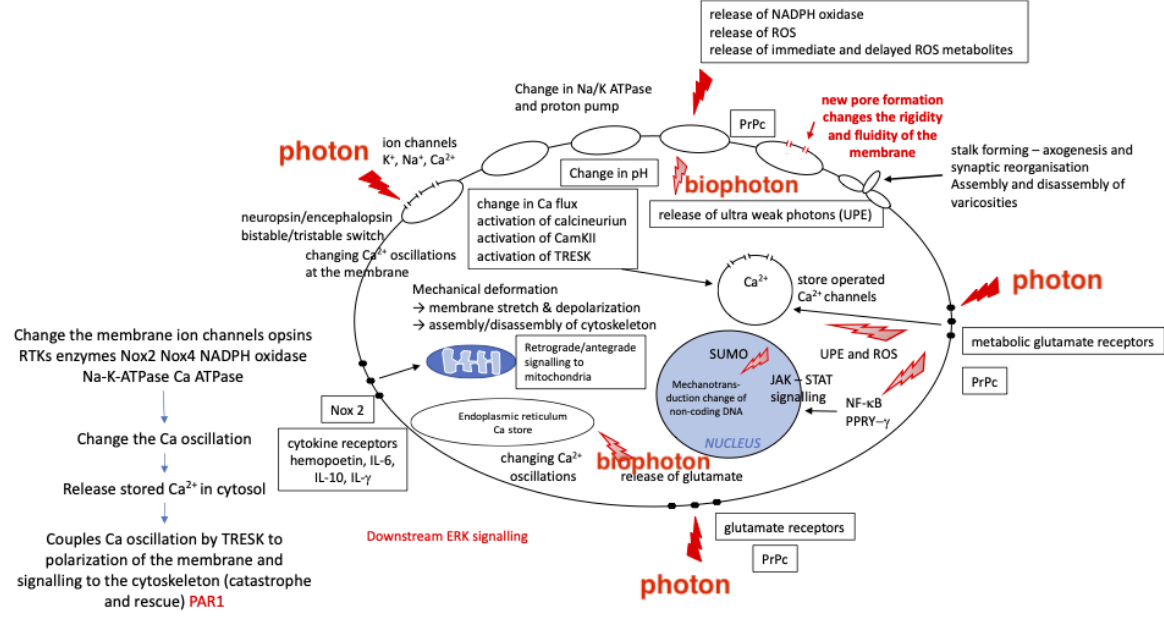
Figure 3. Mechanotransduction influences at a cellular level.